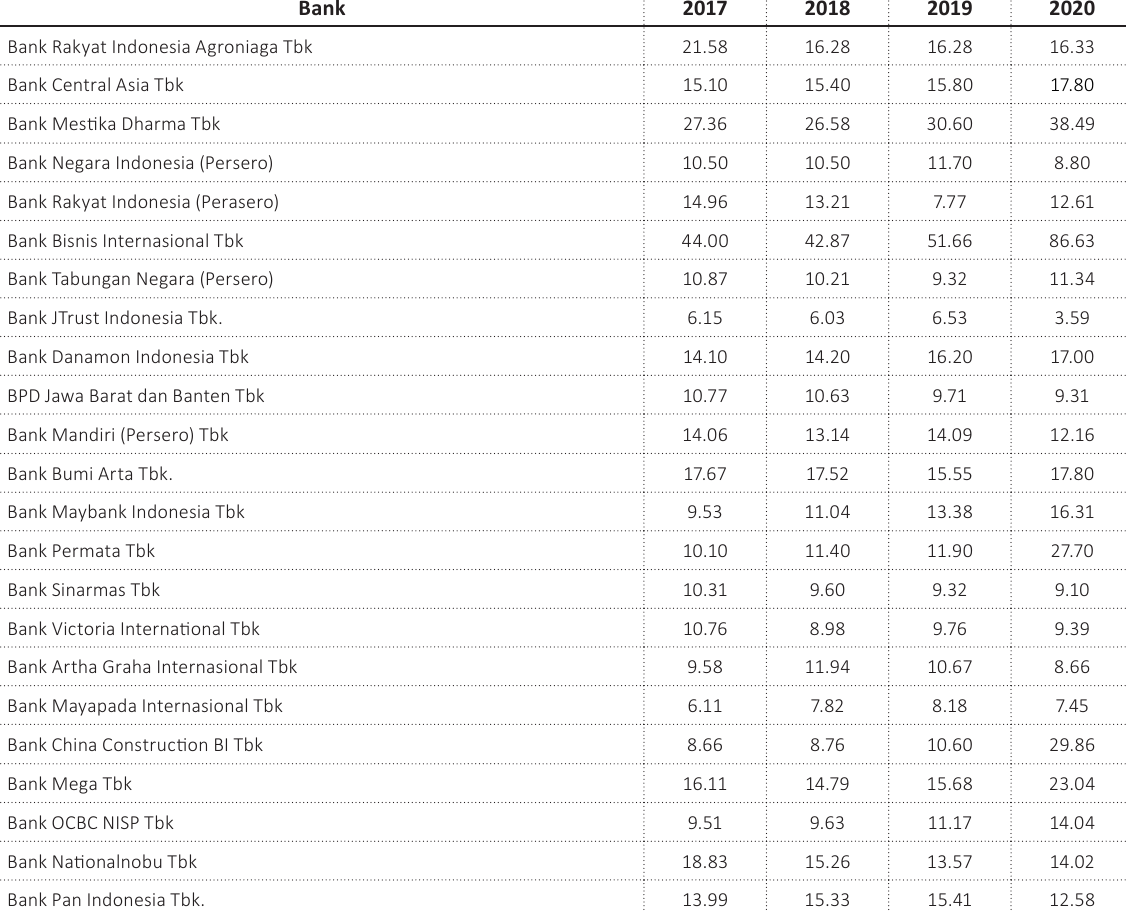
Table A1. Calculation data for the capital buffer component of Indonesian banks for 2017–2020